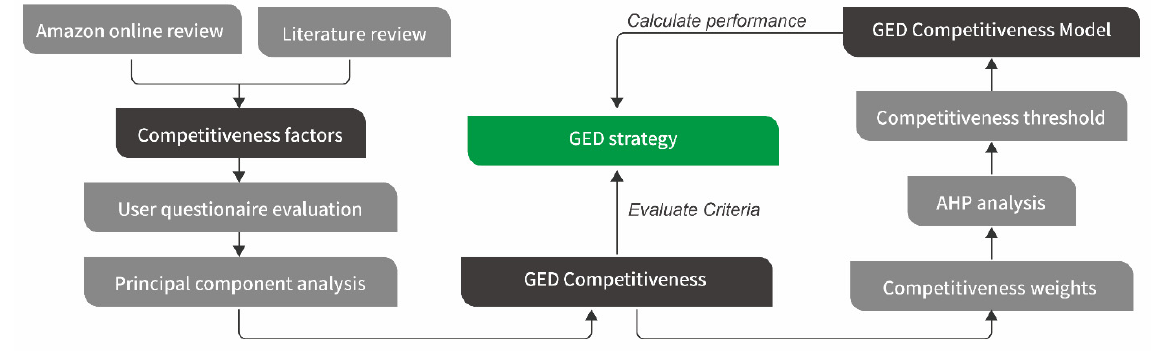
Figure 3. The framework of the GED strategy and its evaluation.